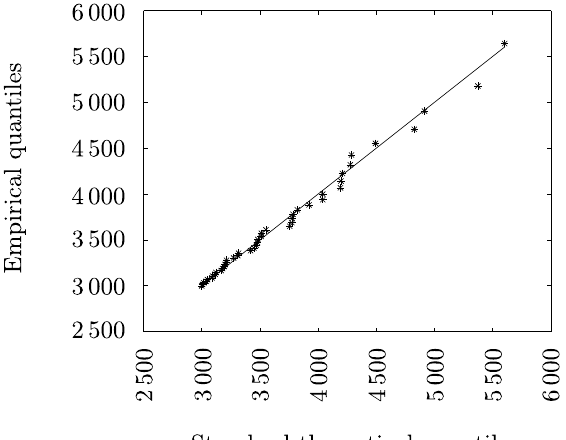
Figure 7: A QQ plot of sample data (same day of the week increases in peak demand above the threshold) versus a GPD.